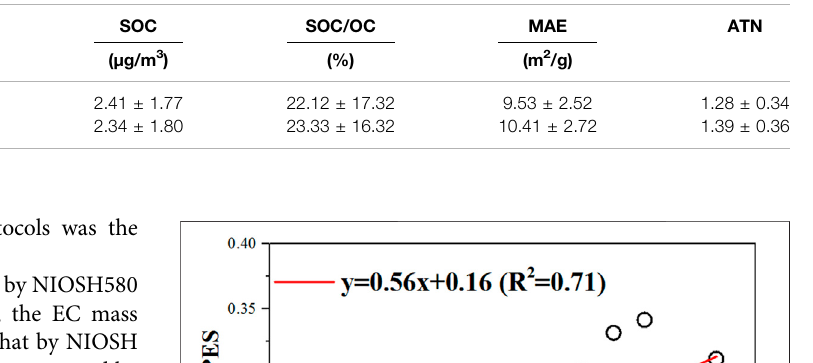
TABLE 2 | The mass concentrations of organic carbon (OC), elemental carbon (EC) and secondary organic carbon (SOC), the ratio of SOC to OC (SOC/OC), the mass absorption ef fi ciency (MAE) and optical attenuation (ATN) at the School of Environment (SE) and at the Station for Observing Regional Processes of the Earth System (SORPES) in May and June of 2016.